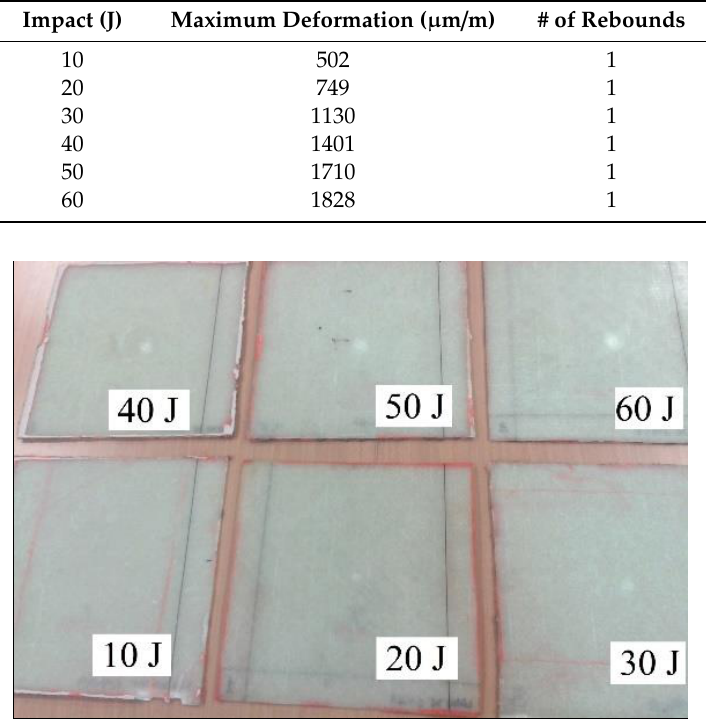
Figure 12. Unmodified panels impacted by vertical weight drop test from 10 J to 60 J of energy.